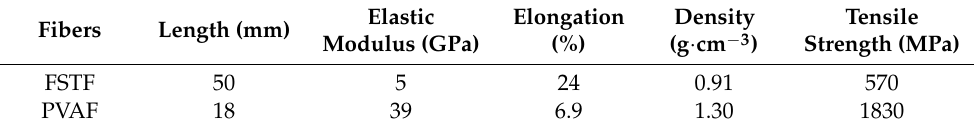
Table 5. Basic performance parameters of